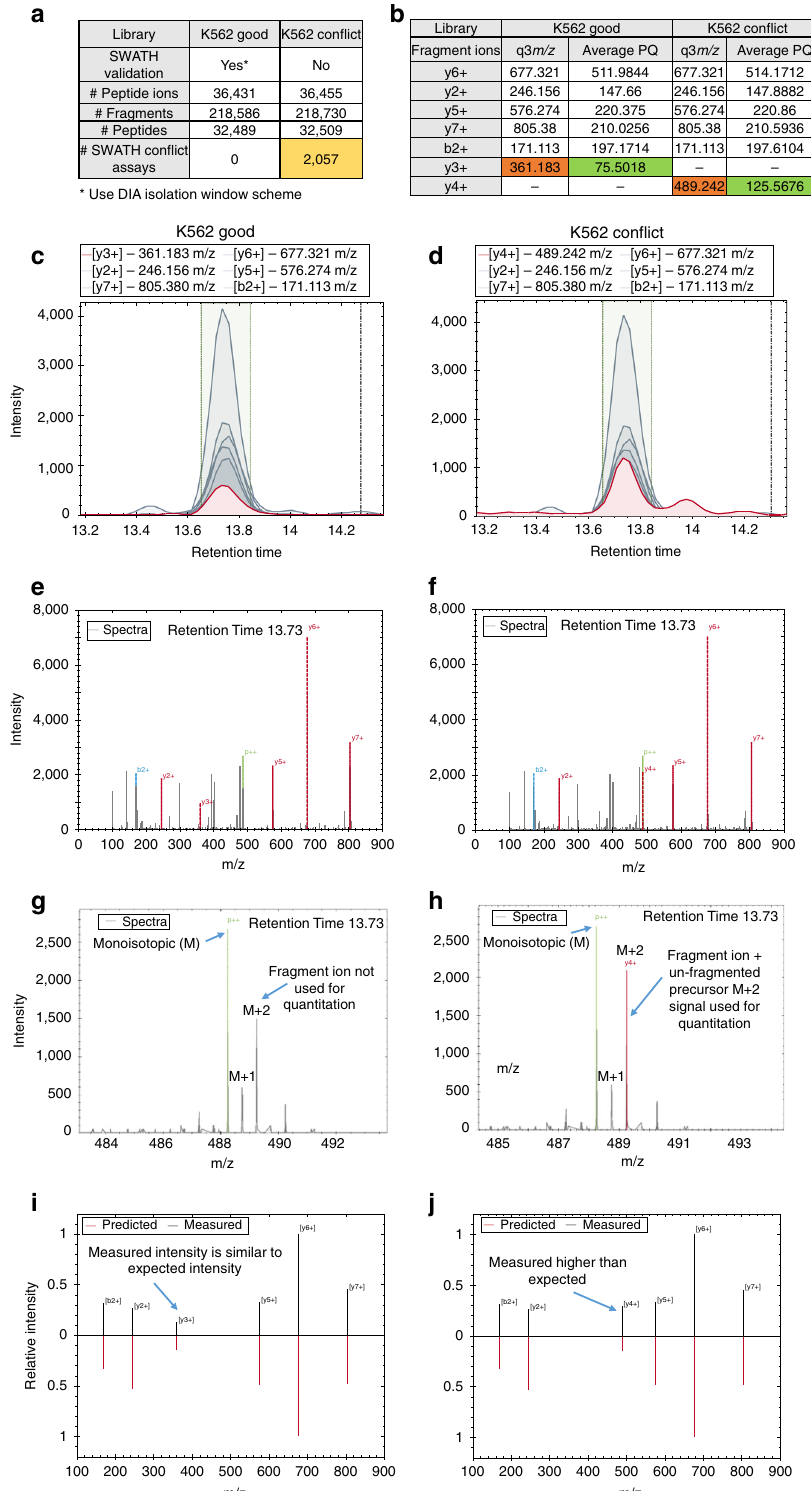
Fig. 3 Effect of con fl ict assay on the peptide quantitation in Spectronaut analysis. a DIALib-QC assessment reports the number of DIA con fl ict assays in both libraries. b Comparison of average peak quantities (PQ) of peptide ion GLQTSQDAR.2 between the two libraries (highlighted in orange and green) for the most intense six fragment ions observed in all fi ve DIA/SWATH replicates. c , d Quantitative MS2 analysis based on extracted ion chromatograms (XICs) of peptide GLQTSQDAR.2 with both libraries eluted at the same RT. e , f MS2 spectrum of peptide GLQTSQDAR.2 in both libraries. p ++ denotes un-fragmented precursor ion with [M + 2H] 2 + charge. g , h Zoomed MS2 spectrum highlighting the overlap of un-fragmented precursor isotopic envelope (M, M + 1, M + 2) with y4 + ion in con fl ict library. i , j Correlation plots between measured (black) and predicted (red) relative fragment y4 + ion intensity showed higher similarity in the good than in the con fl ict